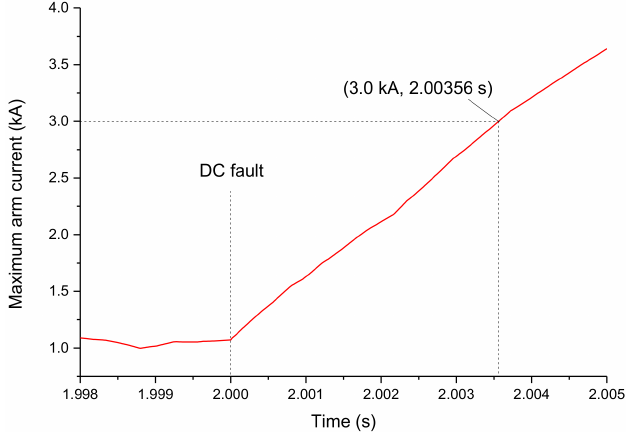
Figure 11. Maximum current of six arms of the MMC.